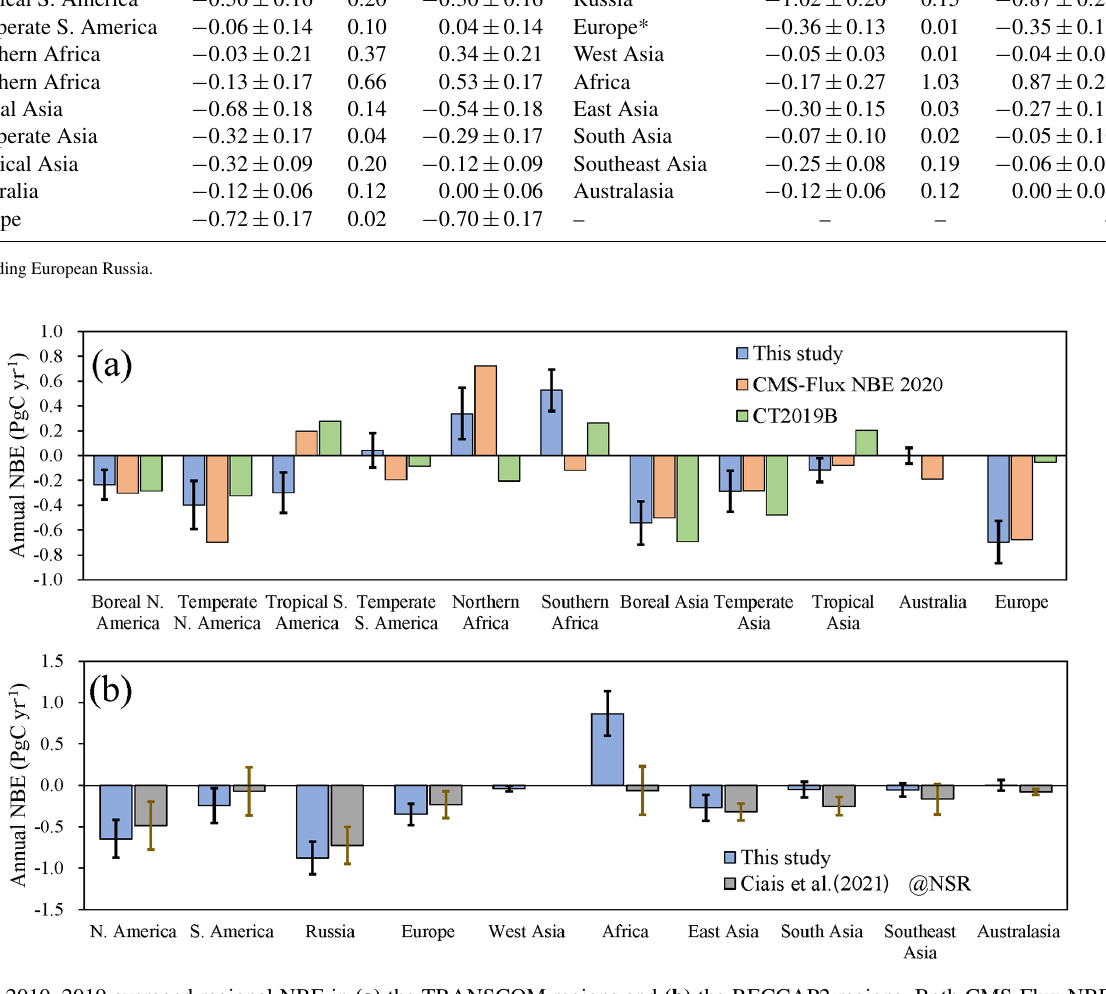
used in these two systems are quite different (a strong sink